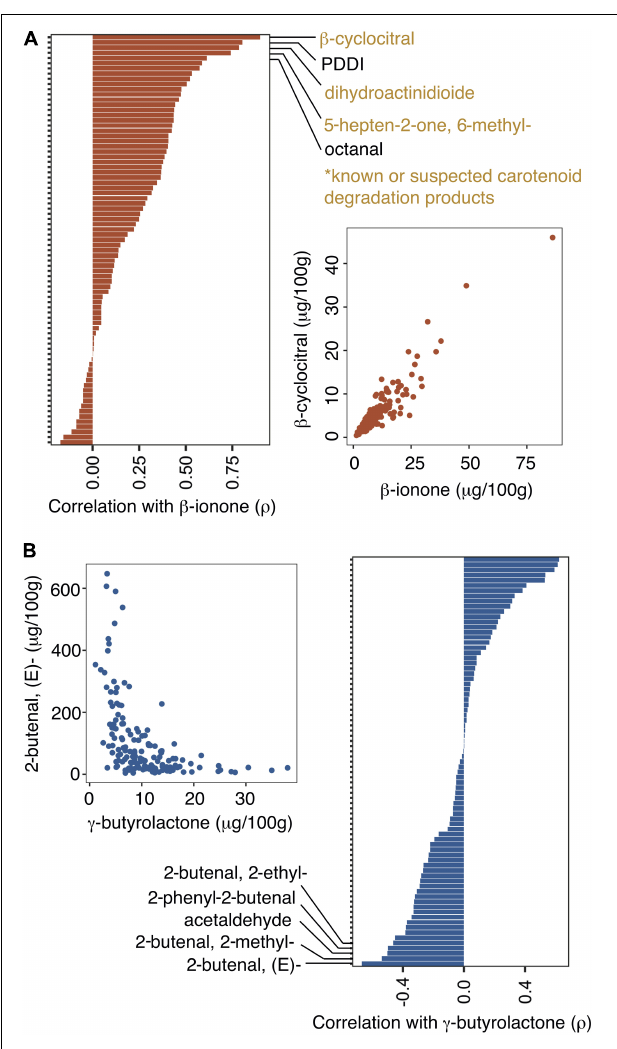
FIGURE 4 | Spearman’s Rank Correlations among fruit volatile traits in 148 date palm fruit samples. (A) Correlations between β -ionone and other volatiles. Selected volatiles mentioned in the text are labeled. (B) Correlations between γ -butyrolactone and other volatiles. Selected volatiles mentioned in the text are labeled.